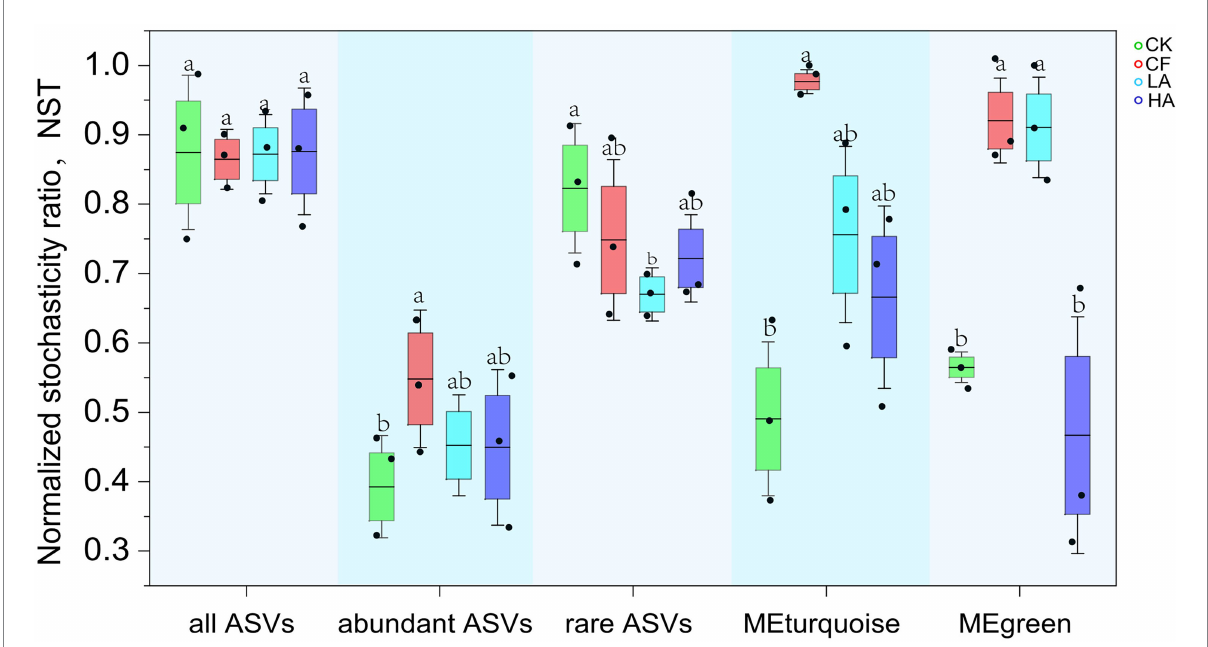
FIGURE 4 Normalized stochasticity ratio of all ASVs, abundant ASVs, rare ASVs, MEturquoise, and MEgreen in different treatments. Different labeled letters indicate significant differences between different treatments according to one-way ANOVA with Duncan’s multiple range tests ( p < 0.05).